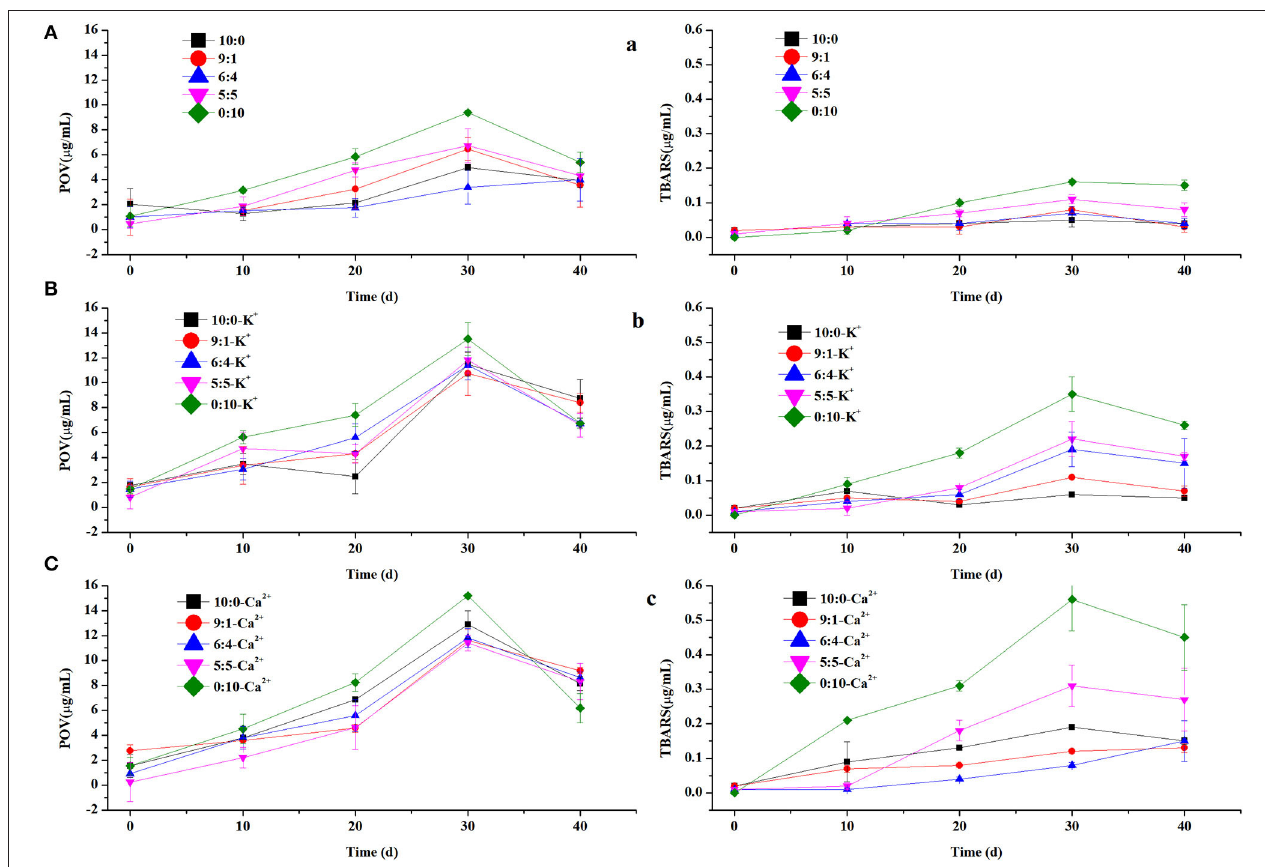
FIGURE 4 | The peroxidevalue (POV) and thiobarbituric acid reactive substances (TBARS) of control, containing K + (A–C) and containing Ca 2 + (a–c) in OPO emulsions (10% v/v OPO human milk fat substitutes and WPI: CN/10:0, 9:1, 6:4, 5:5, 0:10, 1% w/v in total) as